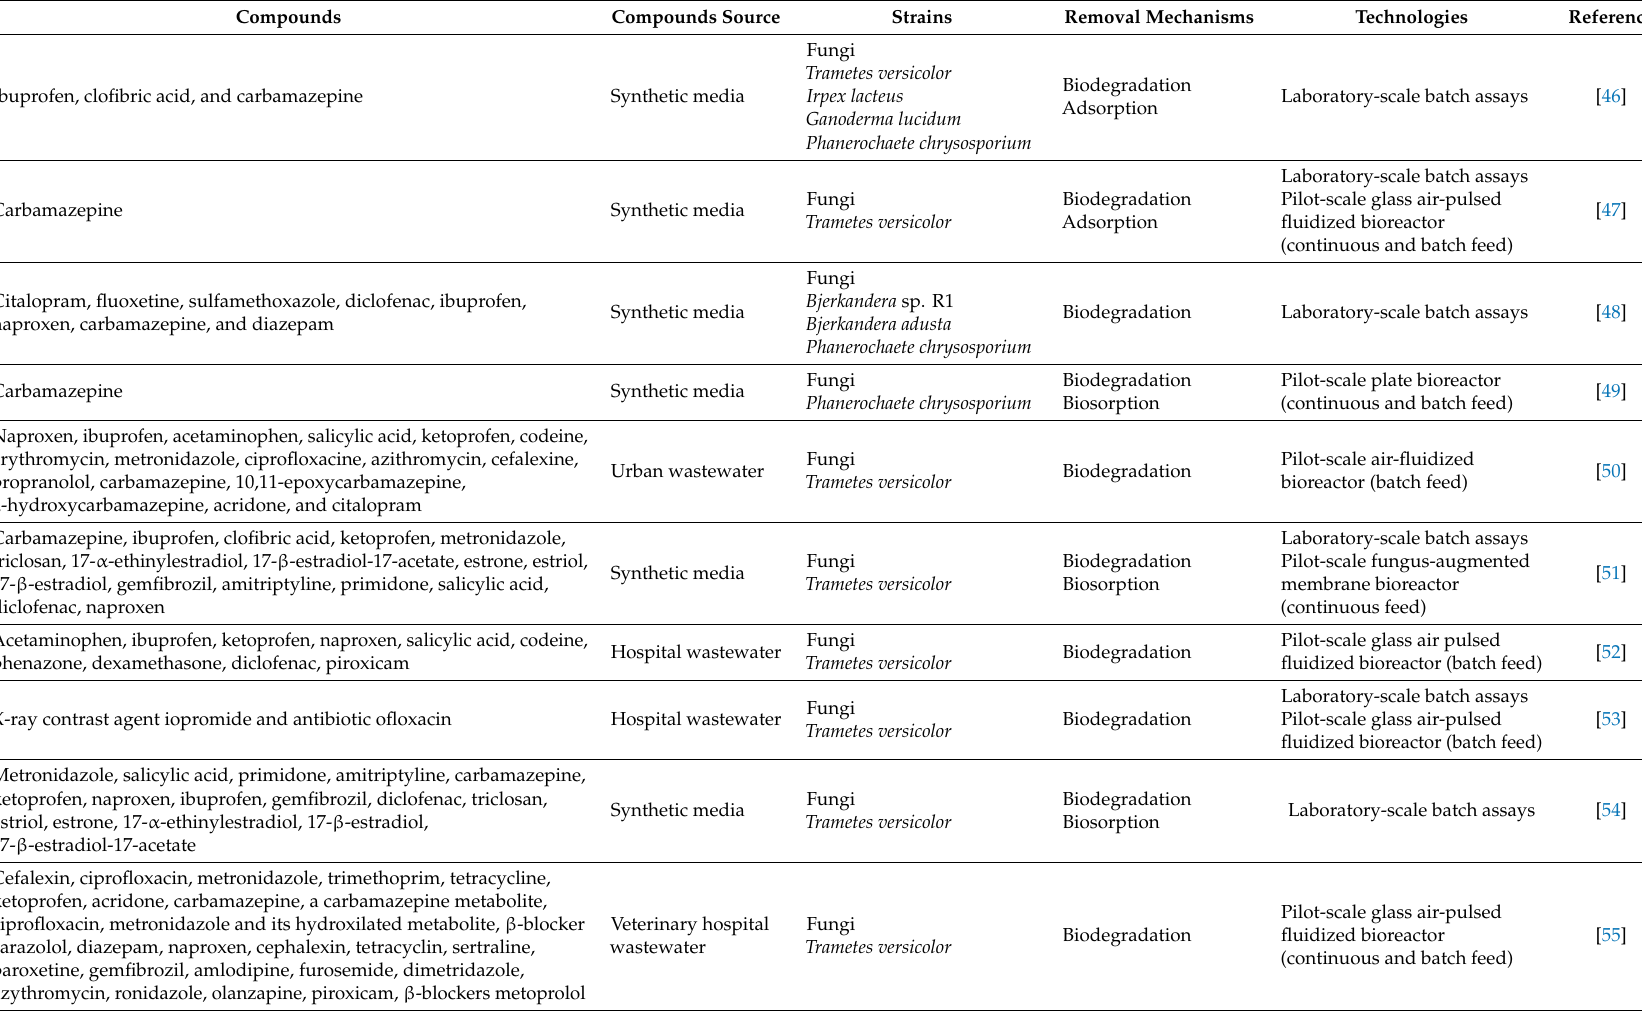
Table 1. Bioremediation studies with fungi and algae for removal of pharmaceuticals. WWTP—wastewater treatment